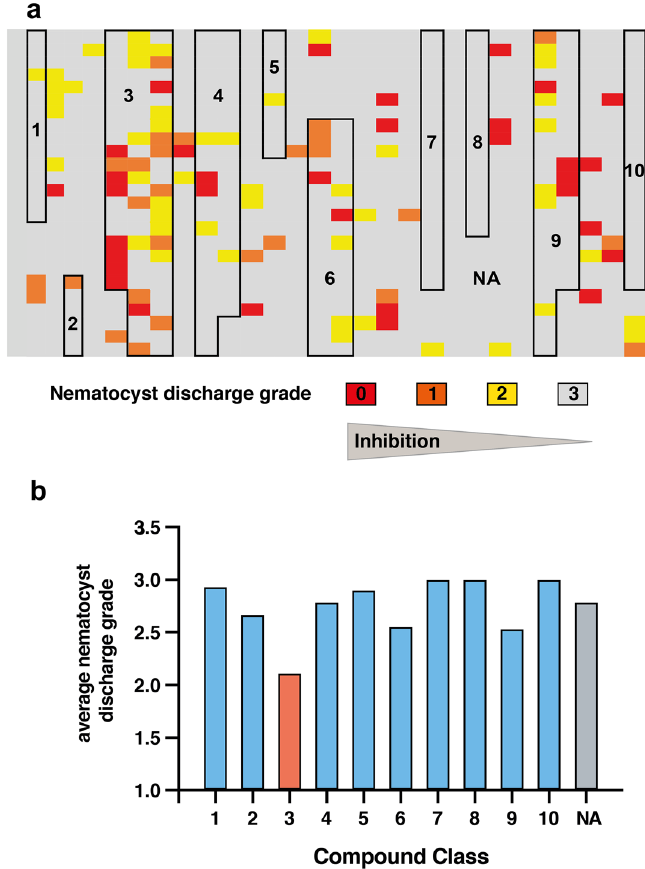
Figure 2. ( a ) Heat map of compound library screen including 700 compounds. 10 selected compound classes are highlighted as indicated. Colors indicate grades of effective nematocyst discharge derived from prey capture efficiency as recorded in the primary screen. Grey, grade 3 (prey capture as in control); yellow, grade 2; orange, grade 1; red, grade 0 (full prey capture inhibition). The applied grades are further detailed in methods. Compound classes are indicated with boxes and numbers. Detailed data are given in Supplementary Table S1 online. ( b ) Average nematocyst discharge grade for tested compound classes applying levels 0–3 obtained from the primary screen (no influence on prey capture equals 3). 1 = pyrazoles, 2 = triazenes, 3 = [2.2]paracyclophanes (orange), 4 = coumarins, 5 = sugars, 6 = (per)fluorinated compounds, 7 = piperazines, 8 = steroids, 9 = azo- compounds, 10 = indole derivatives. NA (not assigned) = compound with no assignment to a certain compound class